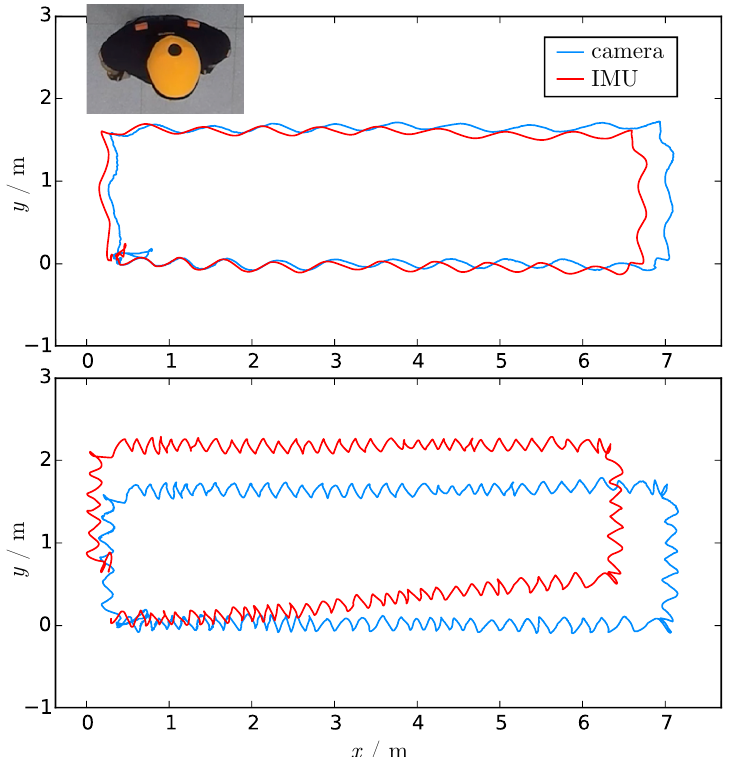
Figure 1. Trajectories of a person’s head walking along a rectangle with the same position being the start and the end. The blue path results from a camera system detecting and tracking a black dot on an orange cap. The red path is the head trajectory of the used IMU-based system which is superposed by a drift that increases with time. ( Top ) slow walking with 0.336ms − 1 . ( Bottom ) very slow walking with 0.054ms − 1